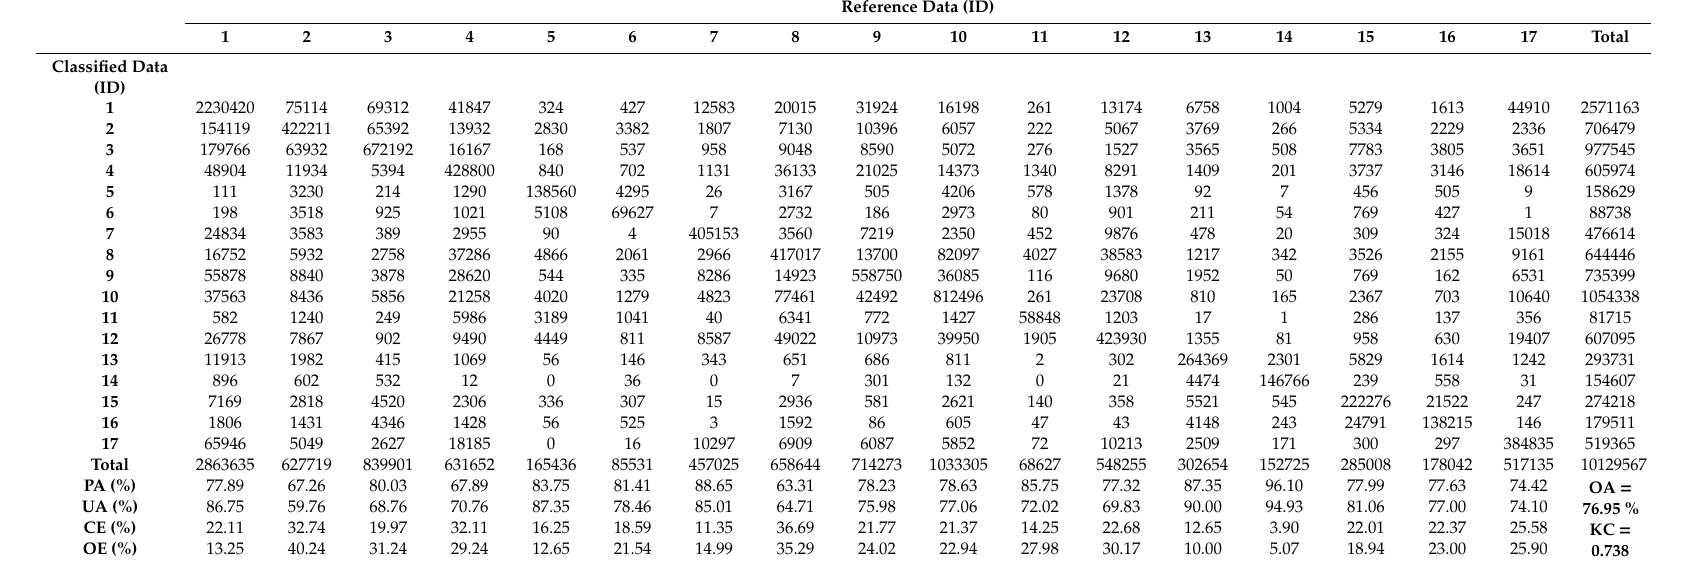
Table 4. Confusion matrix of the produced Annual Space-Based Crop Inventory (ACI) map in terms of the number of